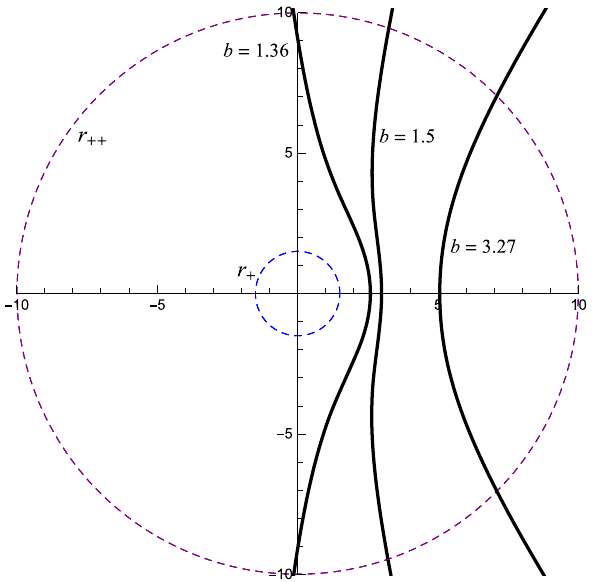
Fig. 3 Scattering of particles for different impact parameters b = 1 . 36 , 1 . 5 and 3 . 27. It is observed that the scattering process can be attractive or repulsive, depending on the impact parameter. The plots have been done for Q = 1 and λ = 10